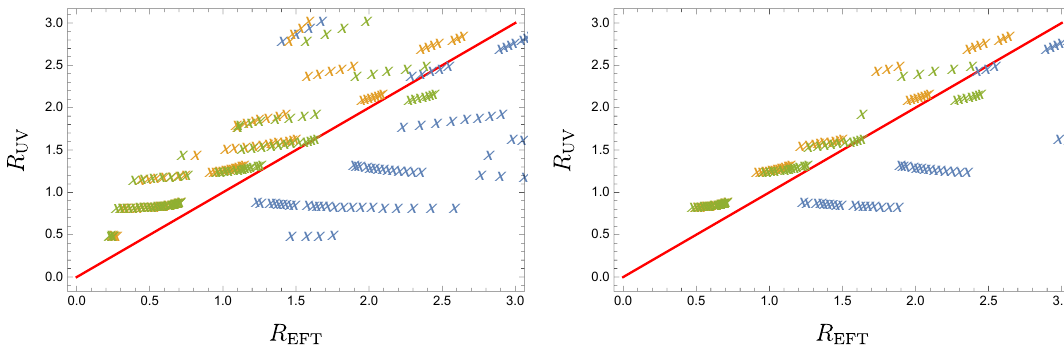
Figure 3. ( R N ) EFT on the x-axis vs. ( R N ) UV on the y-axis for points from the singlet scan with κ = 4 in figure 2; in the left plot we included all points with c 8 v 2 / Λ 2 < 0 . 5 , and in the right plot all points with c 2 / Λ 2 < 0 . 3 . The red line corresponds to ( R 8 v green points correspond to SMEFT with only dimension 6 operators, SMEFT with dimension 6 and dimension 8 operators, and SMEFT with dimension 6 & 8 and dimension 6 derivative